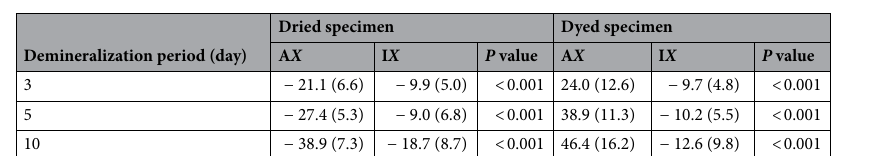
Table 1. Comparison of ΔG of the dried and dyed specimens between active (A X ) and inactive (I X ) groups in different demineralization periods. Mean (standard deviation). ΔG is defined as the brightness of caries lesion compared to that of sound enamel (unit: %). A X indicates active lesions that demineralize for X days; I X indicates inactive lesions that re-mineralize for 10 days after demineralization for X days.